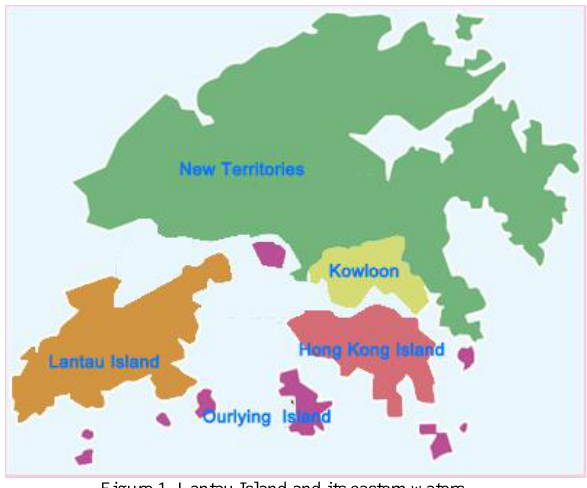
Figure 1. Lantau Island and its eastern waters